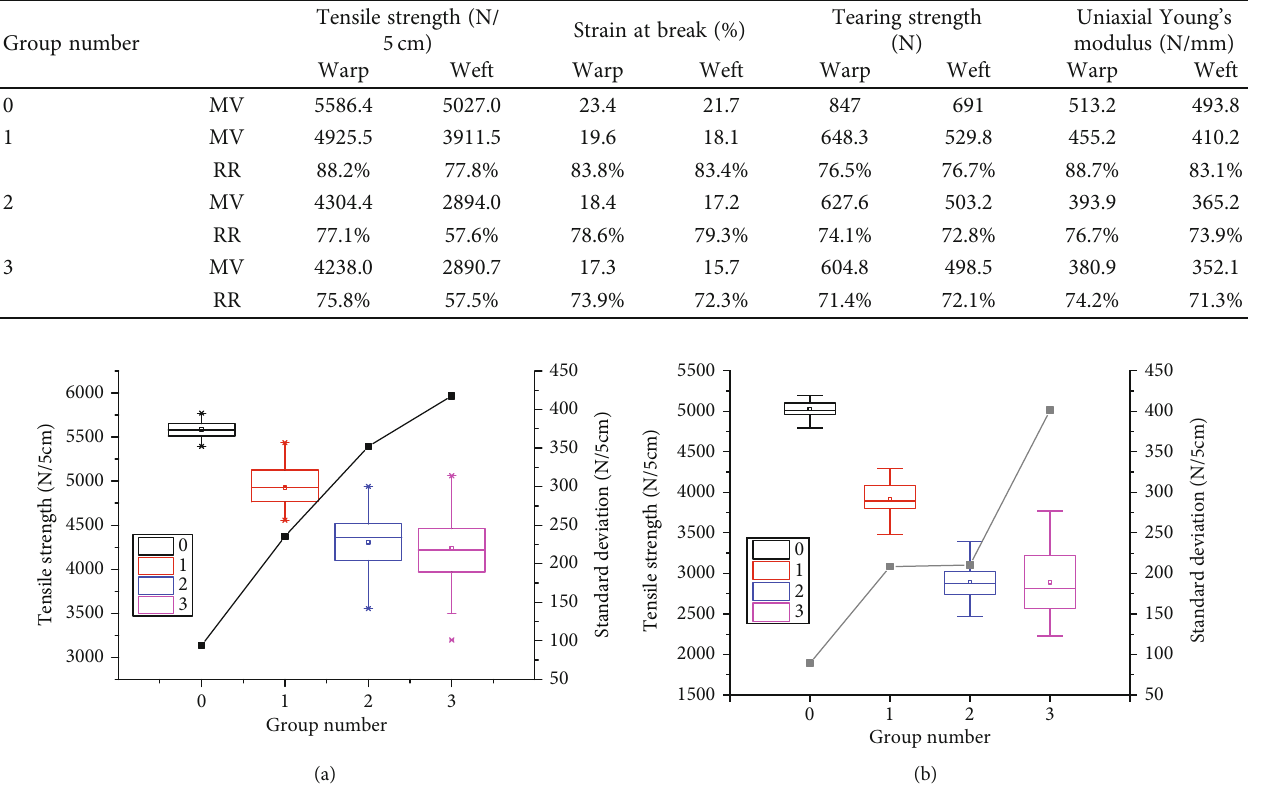
Figure 7: Box plots of tensile strength and the standard deviation of each group of test data: (a) test data in warp direction and (b) test data in weft direction.